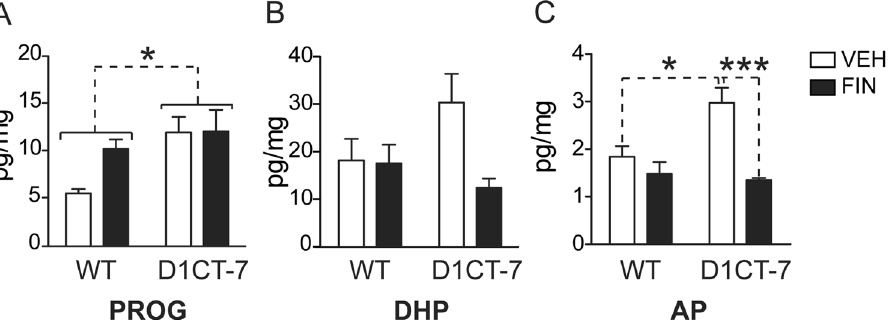
Figure 5. Effects of finasteride (FIN; 50 mg/kg, IP) on levels of ( A ) progesterone, ( B ) 5 α -dihydroprogesterone (DHP) and ( C ) allopregnanolone (AP) in the prefrontal cortex of D1CT-7 and wild-type (WT) littermates following spatial confinement (SC). Data are shown as means ± SEM. ** P < 0.01, and *** P < 0.001 for comparisons indicated by dashed lines. Main effects for genotype are indicated as comparisons between brackets. Main effects for SC are indicated as comparison between symbols. N = 5–7/group. VEH, vehicle. For further details, see text.